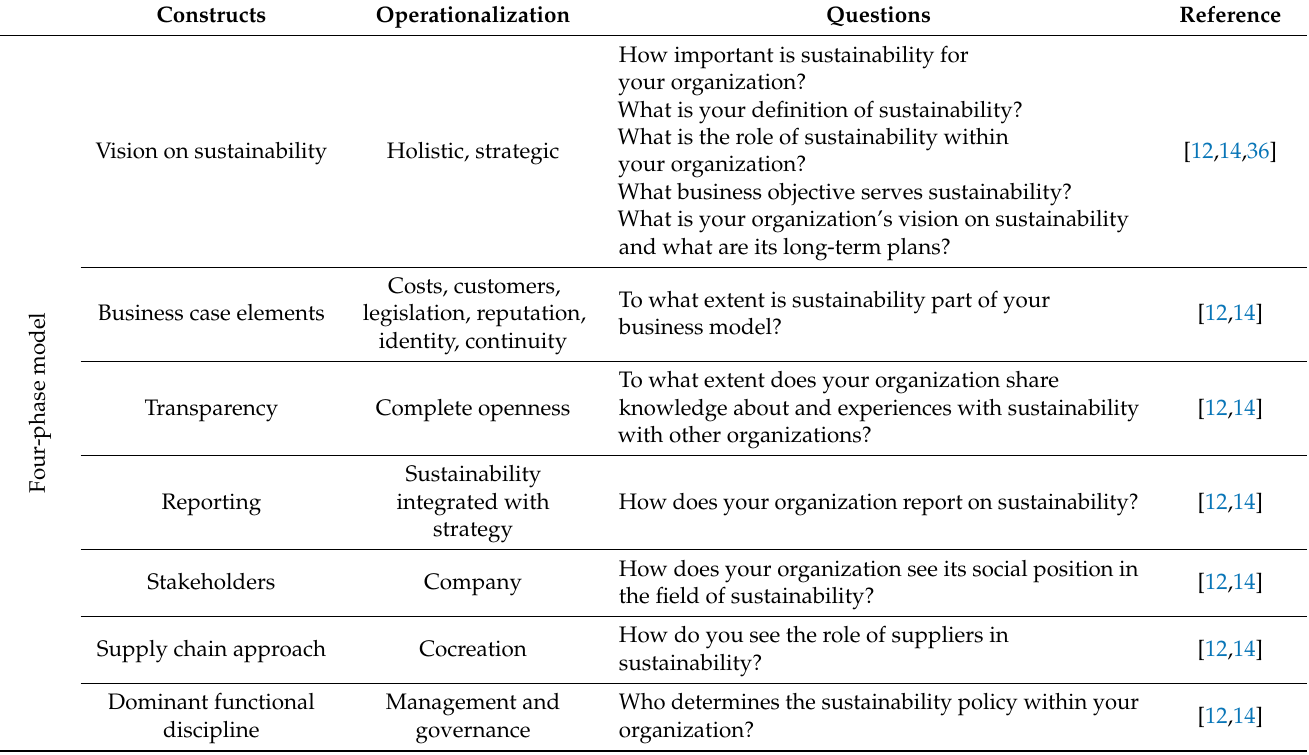
Table A1. Constructs and interview questions to assess transition phase to sustainability.